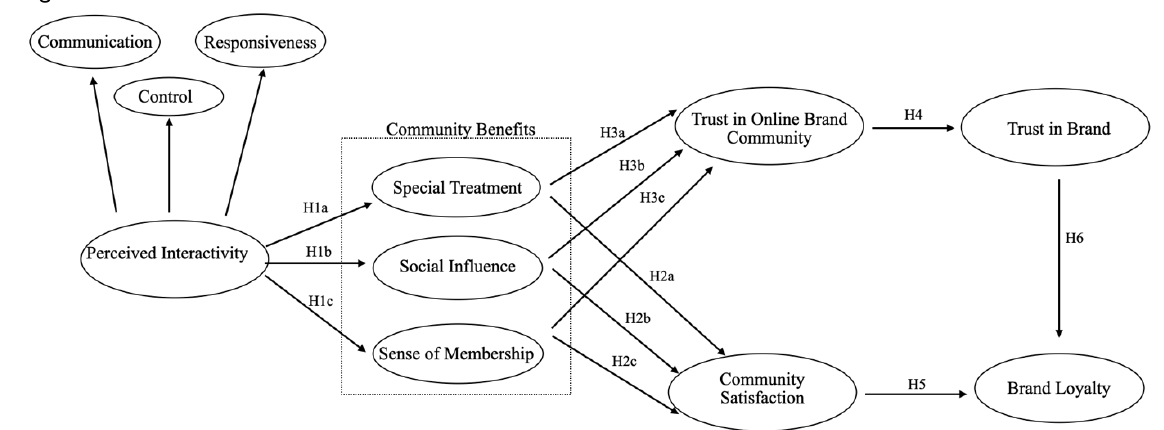
Figure 1. Conceptual Research